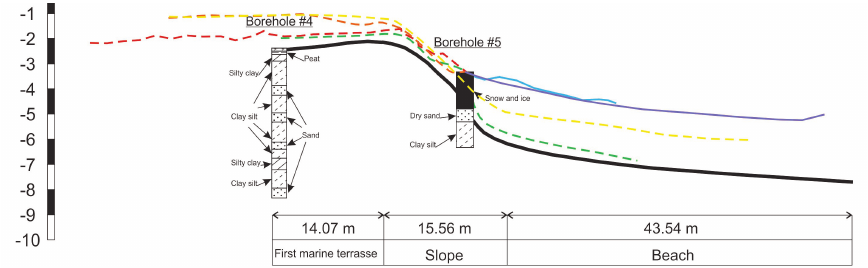
Figure A5. Position of the borehole#4 on profile#3. Image source: SAMCoT report 2015. Nodes are positioned at 0, 5, 10, 16, 27, 35, 44, 55, 86, 100, 115, 130, 145, 164, 180, 204, 220 and 243 cm from the surface.